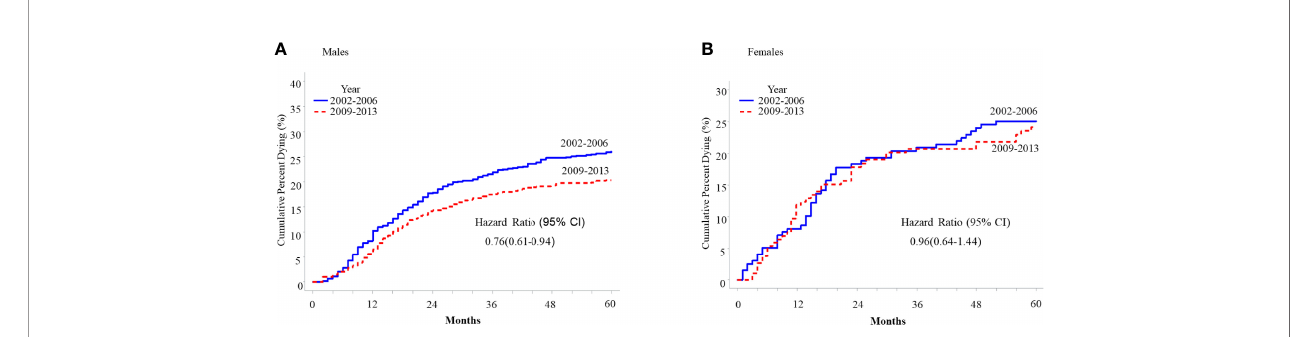
FIGURE 2 | Five-year cumulative probability of death from HPV-related oropharyngeal squamous cell carcinoma (OPSCC) among cancer patients 20-44 years old with HPV-related OPSCC, SEER 2001-2018, strati fi ed by sex. (A) Males (B)